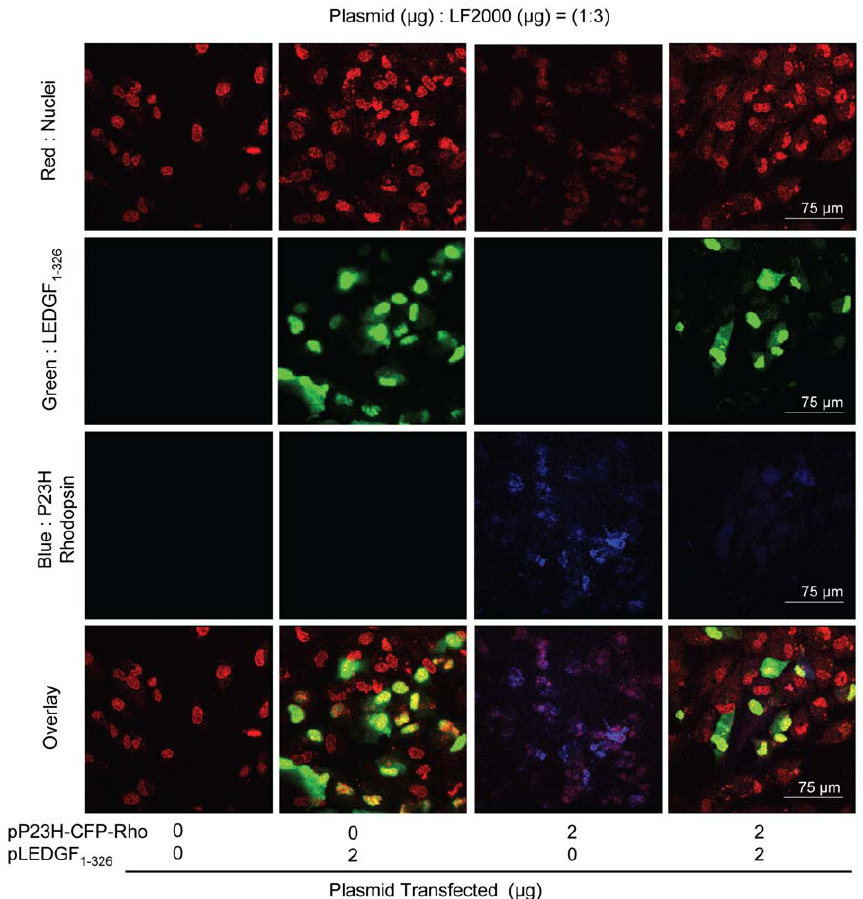
Figure 5. LEDGF 1-326 reduces P23H rhodopsin mediate nuclear damage. Cells were fixed with 4% buffered formalin, permeabilized with 0.2% Triton X-100 and treated with RNase. The nucleus was then stained with TO-PRO-3 iodide. Confocal images were taken using the excitation/ emission wavelengths of 408–450/35, 488–515/30, and 637–605/75 nm for CFP, TO-PRO-3 iodide, and GFP, respectively. Images were analyzed using EZ-C1 3.20 FreeViewer software. Data presents representative images from one of the three independent studies.